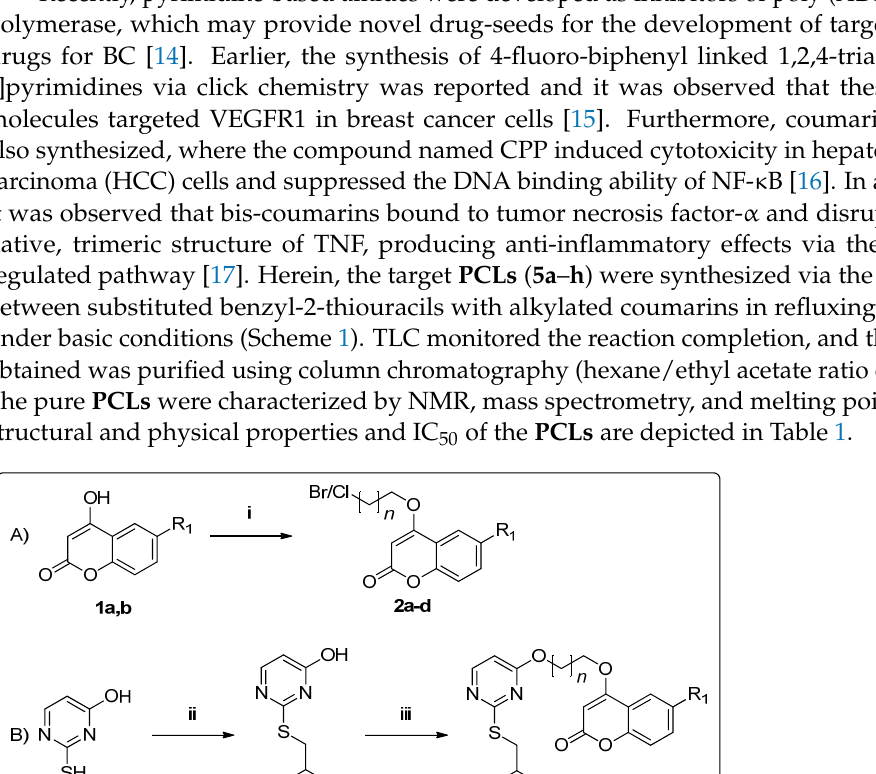
Figure 1. Evolution of newer pyrimidine-linked coumarins (PCLs) as novel chemical entities that target JNK in BC cells.